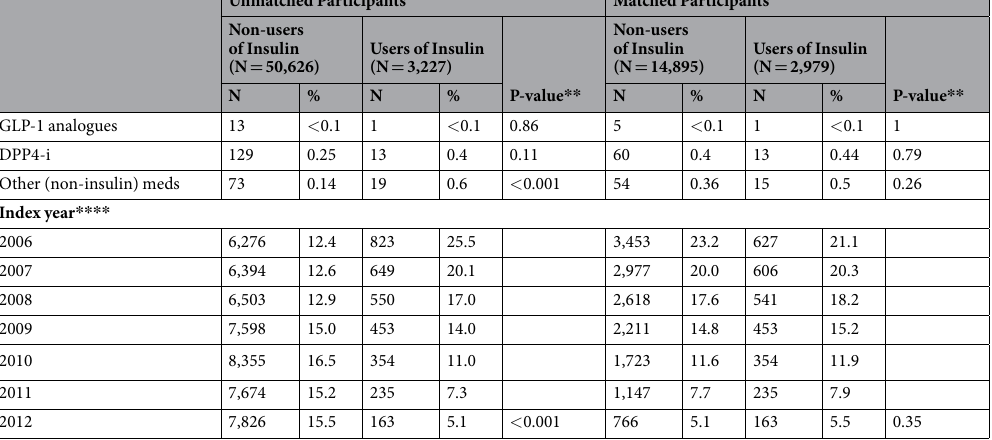
Table 1. Baseline characteristics of patients with incident T2DM stratified by insulin use vs non-insulin use during follow-up. § Although presented here as continuous; BMI and age were entered into PS model as categorical variables incorporating a missing category. ** P-values are reported for chi-square (categorical variables) and t-test (continuous variables), comparing the distribution of baseline characteristics between insulin users and non-users. *** Metformin counted in year prior to index date (other comedications only counted in prior month). **** Index date defined as 01/01/2006 or date of T2DM diagnosis (if after 01/01/2006) or date of enrolment with GP (if after T2DM diagnosis). This was ‘baseline’, and a time-varying covariates model was used, splitting follow-up time at start of insulin use. ∧ Missingness: Non-matched [BMI = 16.0% (non-insulin user), 23.9% (insulin user); HbA1c = 19.7% (non-insulin user), 30.7% (insulin user)]; matched [BMI = 23.8% (non-insulin user), 23.4% (insulin user); HbA1c = 31.8% (non-insulin user), 31.0% (non- insulin user). ± Mean values within each quintile for the propensity score matched cohorts for socio-economic status: Q1 = − 0.14, Q2 = 0.28, Q3 = 0.73, Q4 = 1.21, Q5 = 2.25 (non-user) and Q1 = − 0.38, Q2 = 0.23, Q3 = 0.74, Q4 = 1.20, Q5 = 2.28; for HbA1c: Q1 = 5.32, Q2 = 6.01, Q3 = 6.44, Q4 = 6.95, Q5 = 8.88 (non-user) and Q1 = 5.27, Q2 = 6.00, Q3 = 6.45, Q4 = 9.97, Q5 = 9.66 (user). Abbreviations: Type 2 diabetes